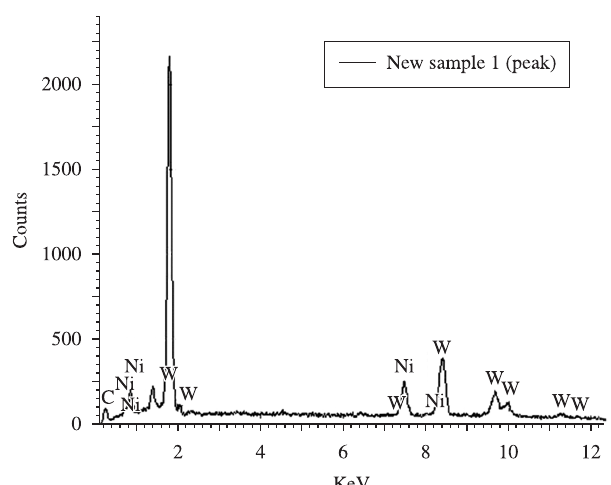
Figure 3. EDS analysis for powders milled for 1 hour.